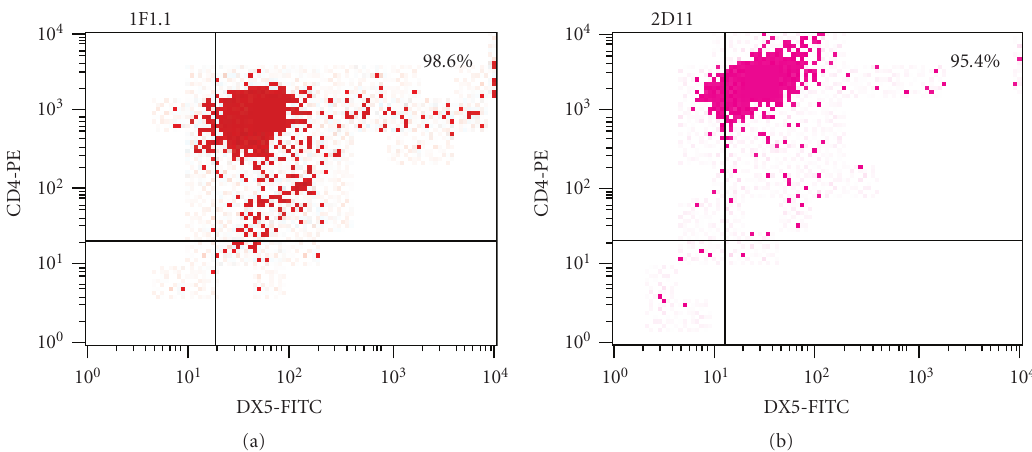
Figure 5: Surface phenotypic expression of two iNKT cell lines by two-color flow cytometry. Cells stained with mouse monoclonalantibody CD4-PE and DX5-FITC were analyzed after a side scatter versus forward scatter gate on live lymphocytes. Both iNKT clones showed a double-positive expression CD4 + DX5 + on their surface. Line 1F1.1 showed a pure population of > 98% and line 2D11 > 95%.